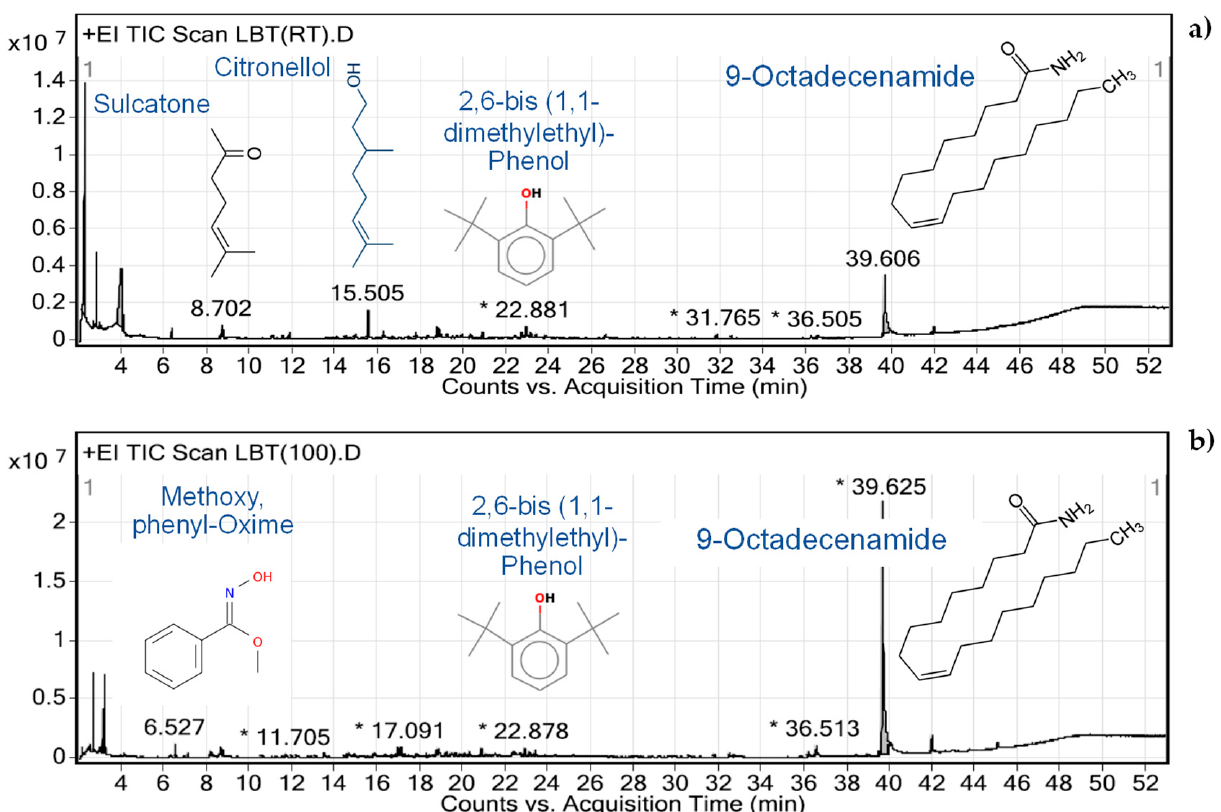
Figure 4. The gas chromatograph–mass spectrometer (GC–MS) chromatograms of: ( a ) M-LBS and ( b ) D-LBS aqueous extracts. * is peak overlapping.